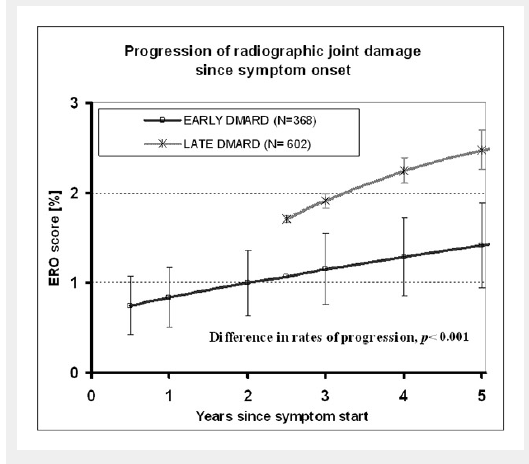
Progression of joint erosion score (Ratingen) over time in patients treated early vs patients treated late with disease-modifying antirheumatic drugs (DMARDs). Mean erosion (ERO) scores (± SEM) are shown as percentages of maximum damage score as a function of time since symptom onset. Regression analysis with adjustment for potential confounders of radiographic progression revealed a significant difference in the slopes of radiographic damage